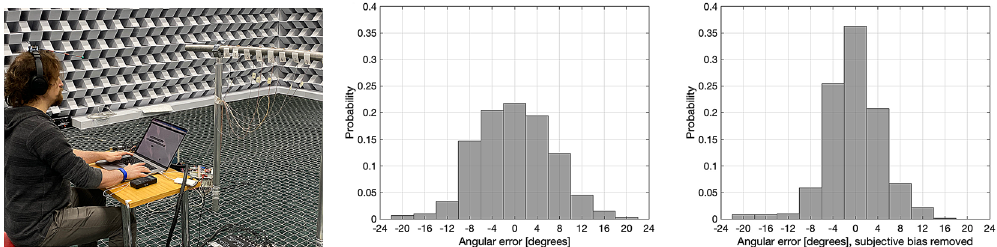
Figure 2. Left: The listening test arrangement. Centre: Distribution of azimuth angular errors in identification of sources, N = 12 , 66 repetitions. Data plotted with individual bias mainly caused by the orientation of the head-worn device. Right: Data plotted after removal of individual